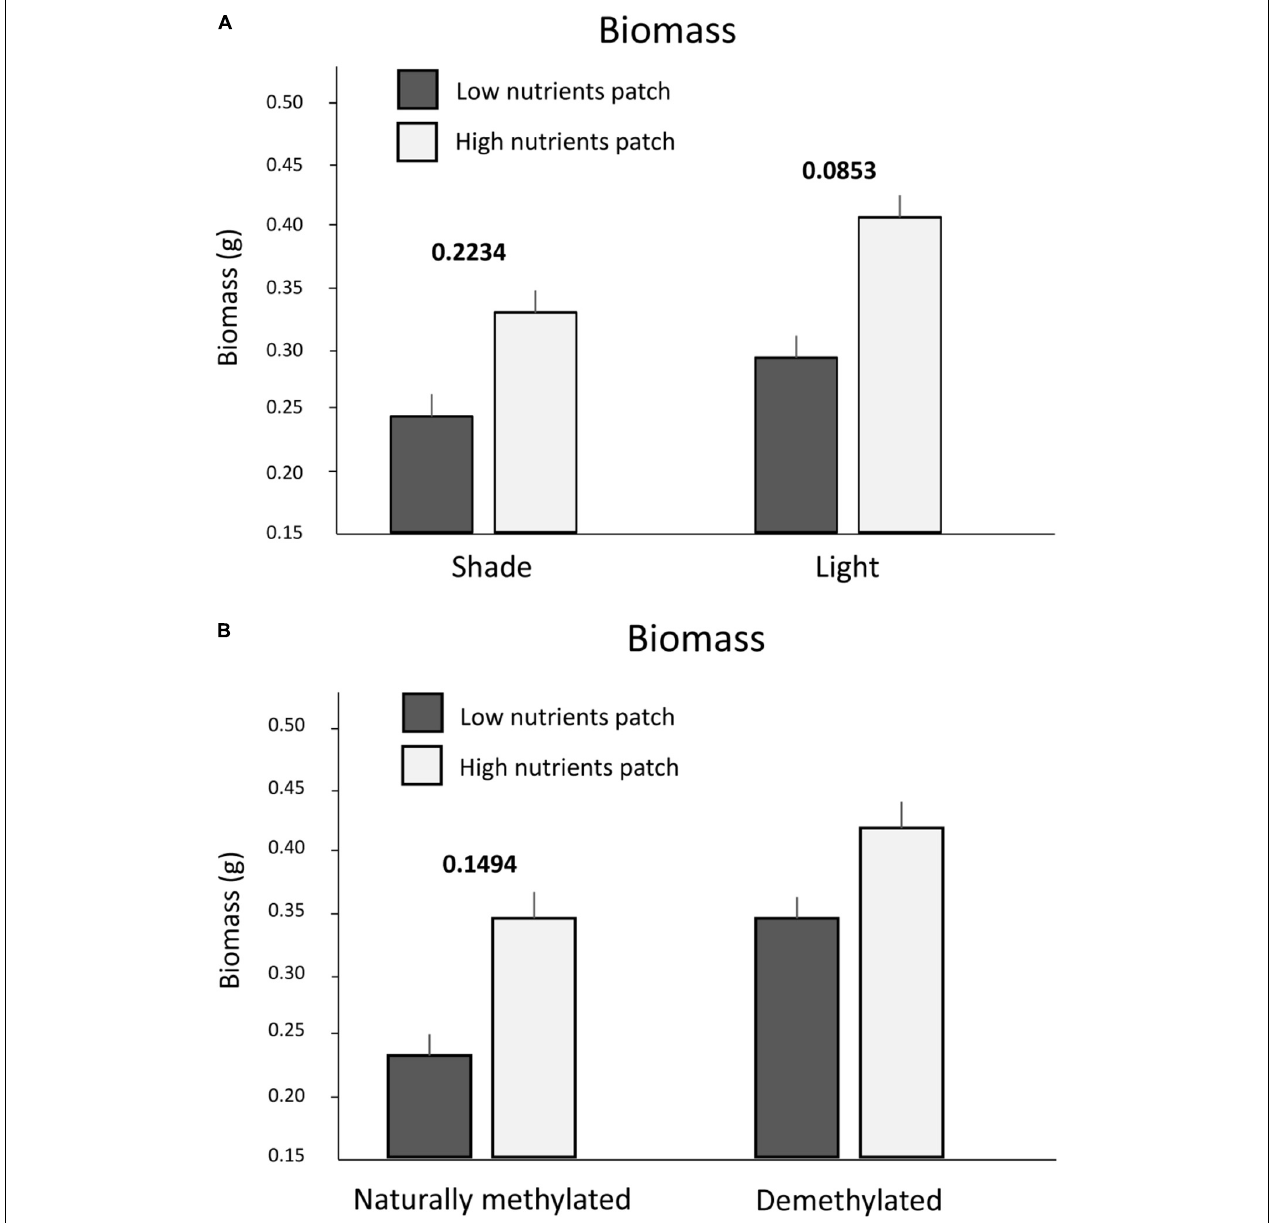
FIGURE 2 | Biomass production in the training zone of nutrient heterogeneous plots. Presented are only significant interactions between nutrients and light intensity. (A) Biomass production in shade and light and nutrient rich or poor patches. (B) Biomass production in nutrient rich or poor patches of naturally methylated and experimentally demethylated clones. Means and SE are shown. Above each pair of columns, we show the values of significant ( p < 0.05) in bold or marginally significant ( p < 0.1) in italics pair wise marginal effects estimated after accounting for all the other variables entering the corresponding models, see also Section “Materials and Methods.” No value above a pair of columns means no significant marginal